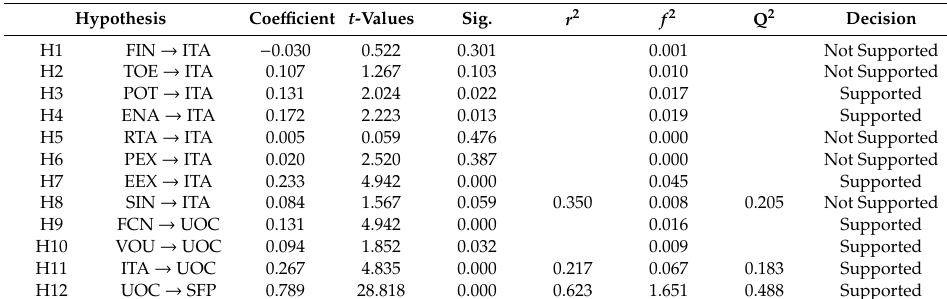
Table 4. Hypothesis